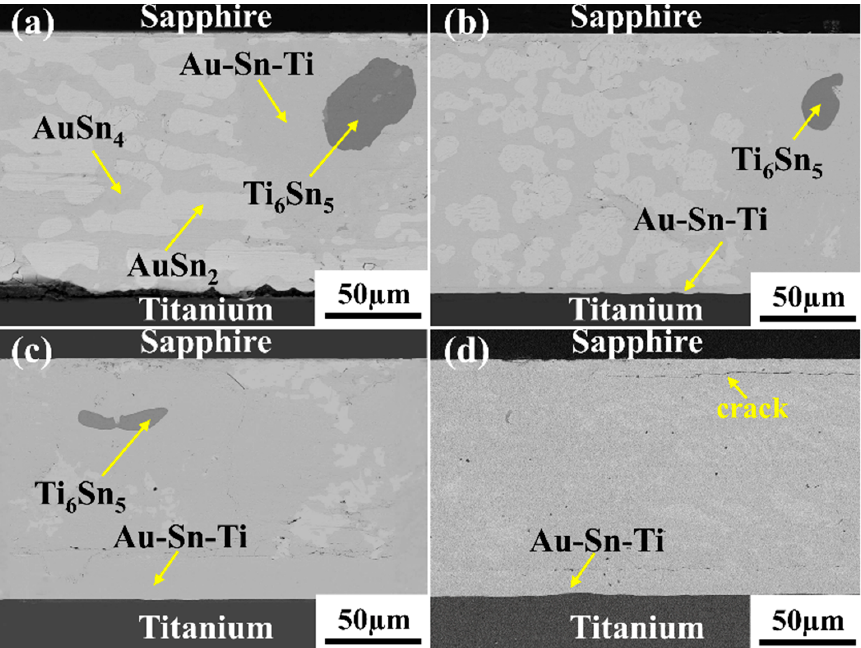
Figure 5. Interfacial microstructure of the titanium/AuSn20/Sn-3Ti/sapphire joints brazed at ( a ) 450 °C, ( b ) 500 °C, ( c ) 600 °C, and ( d ) 650 °C. ( a ) 450 ◦ C, ( b ) 500 ◦ C, ( c ) 600 ◦ C, and ( d ) 650 ◦